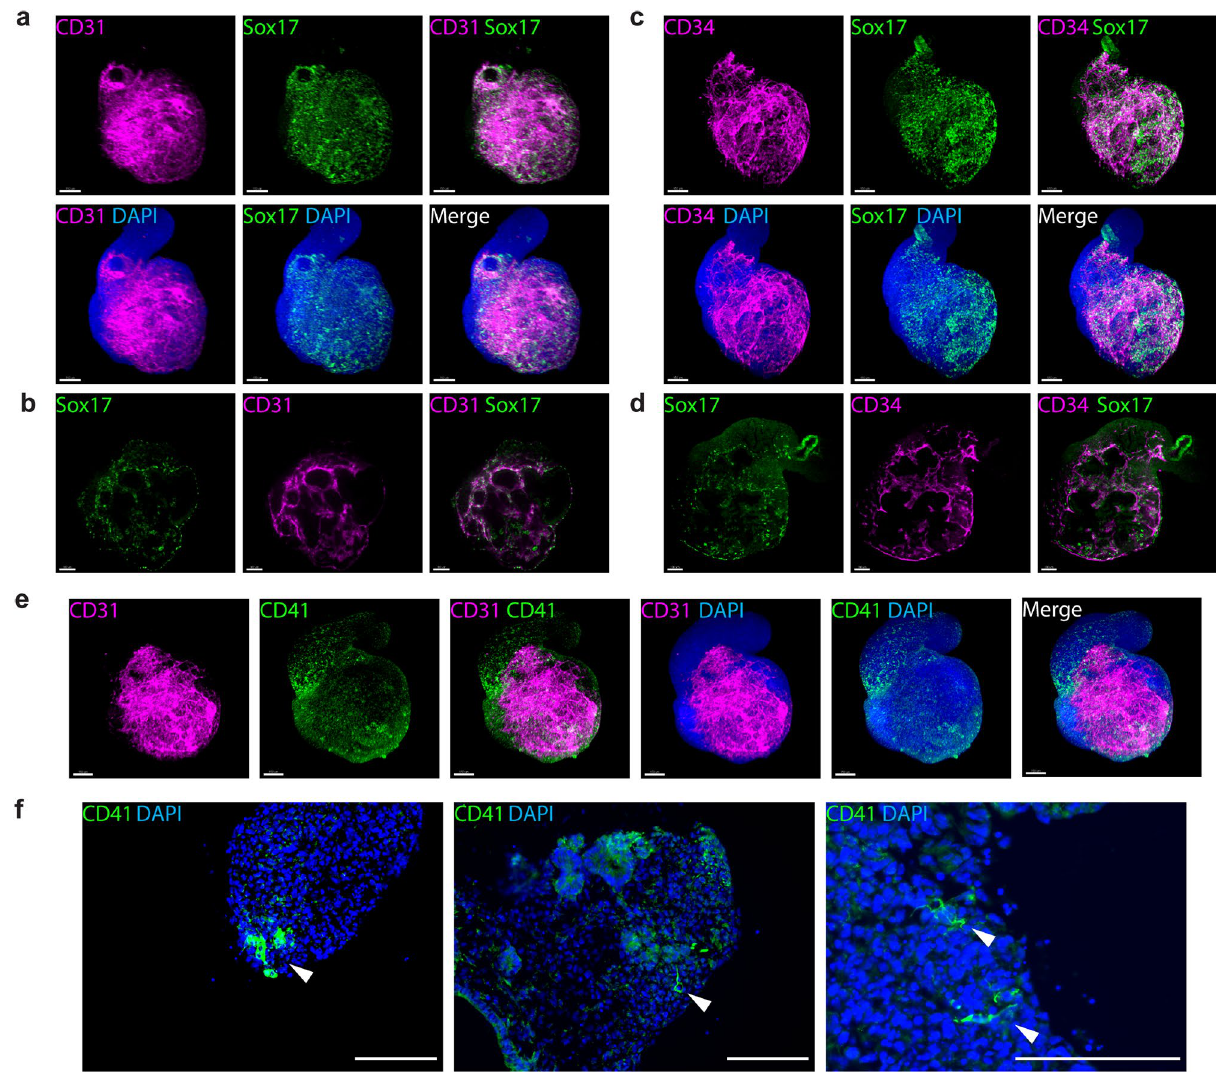
Figure 3. Emergence of blood progenitors in gastruloids. ( a ) Representative light-sheet images of Gata6-Venus gastruloids at 168 h showing the co-expression of CD31 and Sox17 in a 3D reconstruction and ( b ) in a single Z-plane. ( c ) Representative light-sheet images of Gata6-Venus gastruloids at 168 h showing the co-expression of CD34 and Sox17 in a 3D reconstruction and ( d ) a single Z-plane. ( e ) Representative light-sheet images of Gata6-Venus gastruloids at 168 h showing CD41 + clusters that arise near the CD31 + vascular network. ( f ) Representative sections of Gata6-Venus gastruloids at 168 h show CD41 + cells at higher magnification. Scale bars,100